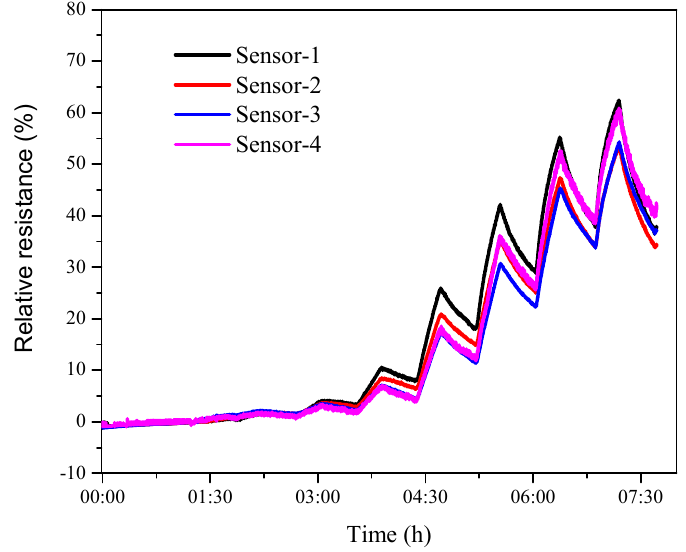
Figure 8. Dynamic responses of different s2DNA-SWNTs toward different concentrations of phenylacetaldehyde vapors performed at V DS = 0.1 V.